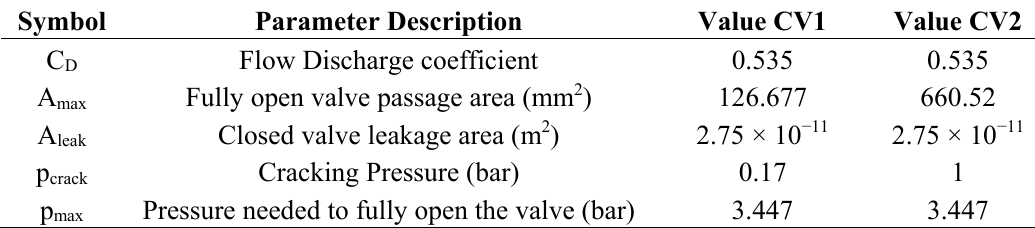
Table 4. Check valve main